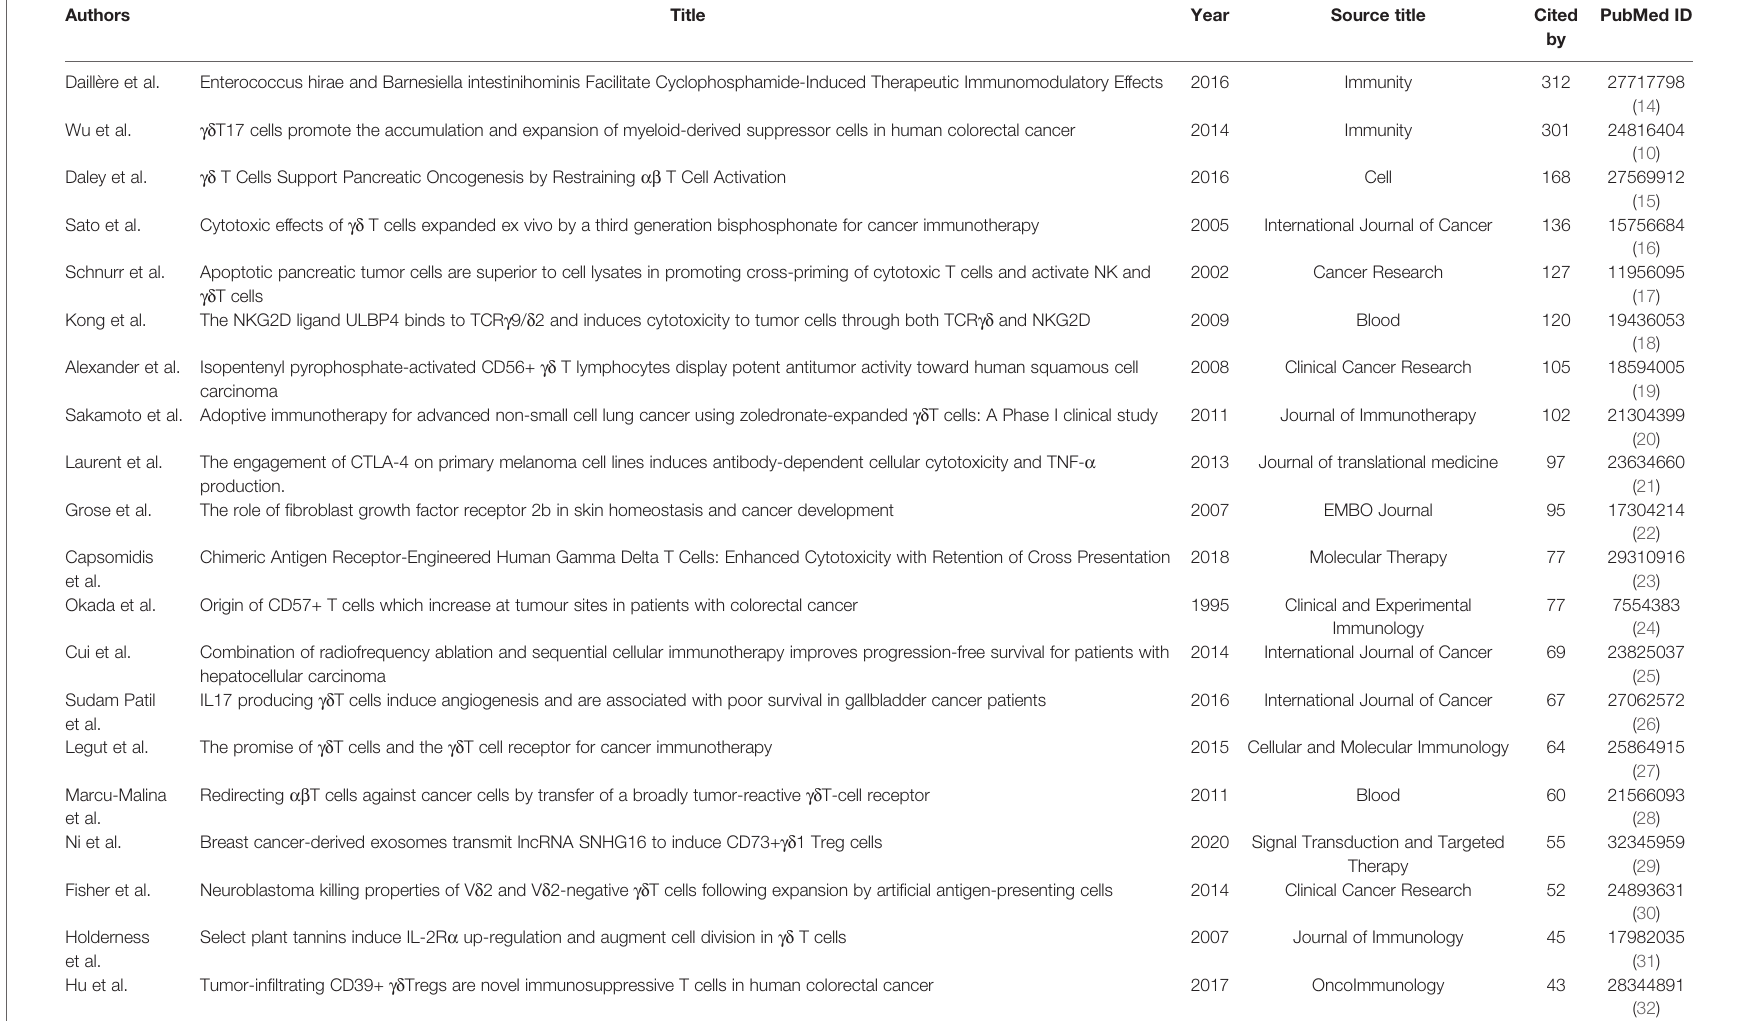
TABLE 1 | Top 20 cited publications studying relationship between gd T cell and